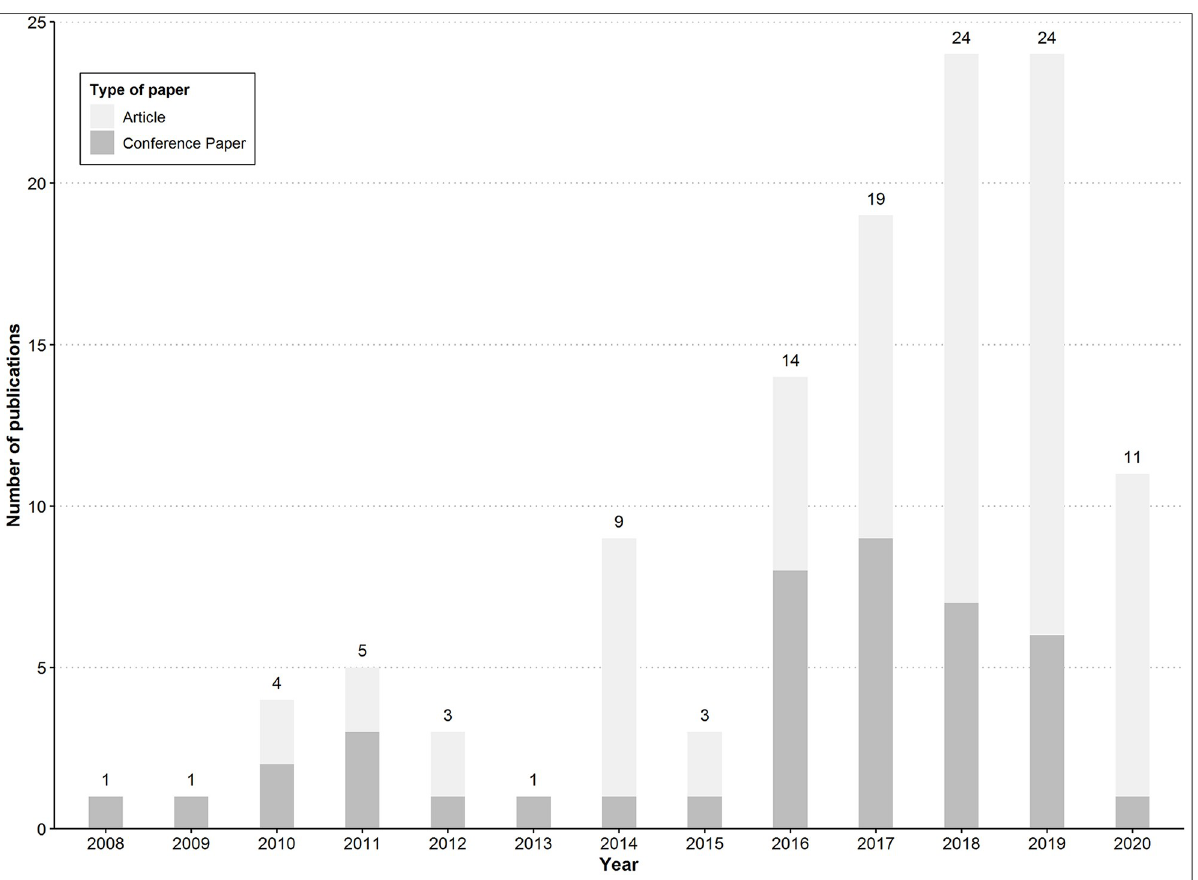
Fig 2. Number of publications on dengue prediction and/or surveillance published between January 1, 2000 and August 31, 2020.